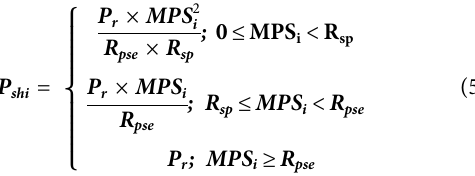
TABLE 3 | Combined probability of solar irradiance and corresponding power for a 30-step model considering farm 1 and farm 2, having combined rated power 1500 MW and σ (cid:2) 229 . 6488 Step Irradiation value value (W/m 2 )